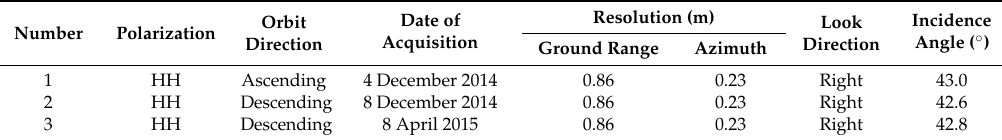
Table 1. Detailed image information.